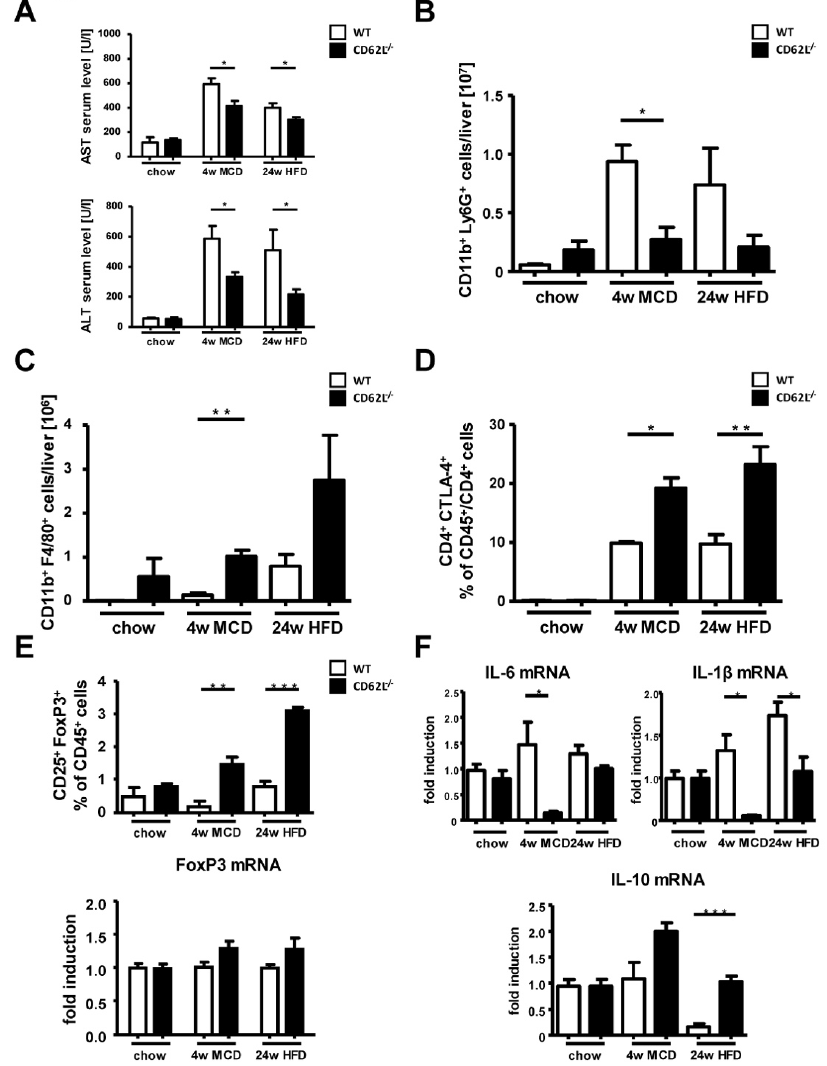
Figure 3. Stronger anti-inflammatory changes in the composition of immune modulatory cells in CD62L − / − mice during steatohepatitis-inducing diets. ( A ) Serum aspartate aminotransferase (AST) and alanine aminotransferase (ALT) levels of wild type (WT) and CD62L − / − animals after chow, 4 weeks MCD or 24 weeks HFD treatment. (* p < 0.05). ( B ) Total numbers of intrahepatic neutrophils were analysed by FACS. Cells were gated by FSC / SSC; duplets were excluded. Live / CD45 + , CD11b + / Ly6G + were regarded as neutrophils (* p < 0.05). ( C ) Total cell numbers of intrahepatic CD11b + / F4 / 80 + cells were analysed by FACS. Cells were gated by FSC / SSC; duplets were excluded. Live / CD45 + , then gated on CD11b + and F4 / 80 + (** p < 0.01). ( D ) Intrahepatic CD4 + / CTLA4 + T cells were analysed by FACS. CD4 + / CTLA4 + T cells were gated by FSC / SSC, duplets were excluded, Live / CD45 + , CD4 + / CTLA4 + . A statistical analysis of the amount of CD4 + / CTLA4 + cells of recorded CD45 + cells was performed. (* p < 0.05, ** p < 0.01). ( E ) Intrahepatic CD25 + / FoxP3 + cells were analysed by FACS. Cells were gated by FSC / SSC, duplets were excluded, Live / CD45 + , CD4 + , CD25 + / FoxP3 + . A statistical analysis of the percentage of CD25 + / FoxP3 + of recorded CD45 + cells was performed. Whole livers of chow, MCD and HFD fed WT and CD62L − / − mice were analysed for FoxP3 mRNA expression via RT-qPCR (** p < 0.01, *** p < 0.001) and values expressed as fold induction over the mean values obtained for chow fed WT liver tissue. ( F ) Whole liver homogenates of chow, MCD and HFD fed WT and CD62L − / − mice were analysed for IL-6, IL-1 β and IL-10 mRNA expression via RT-qPCR and values expressed as fold induction over the mean values obtained for WT liver tissue (* p < 0.05, ** p < 0.01). All data are expressed as mean ± SEM ( n = 8). All experiments were repeated at least